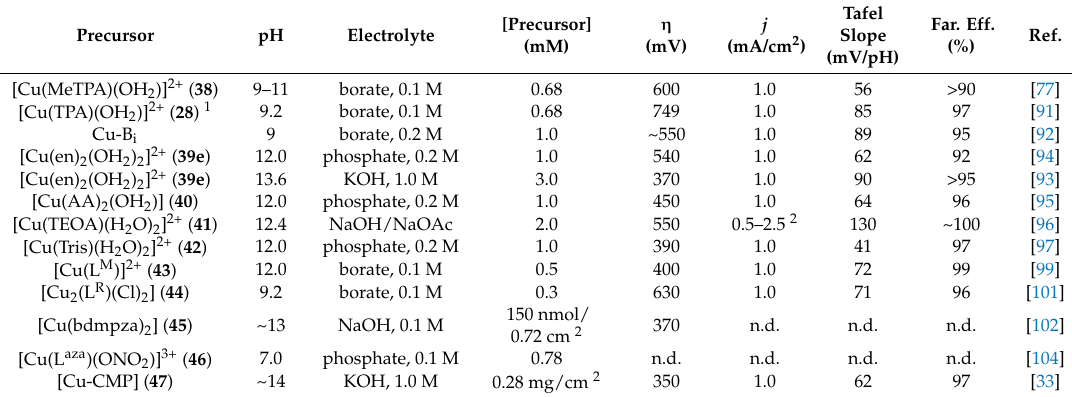
Table 5. Electrochemical data and reaction conditions of Cu precursor complexes and the in situ formed catalytic